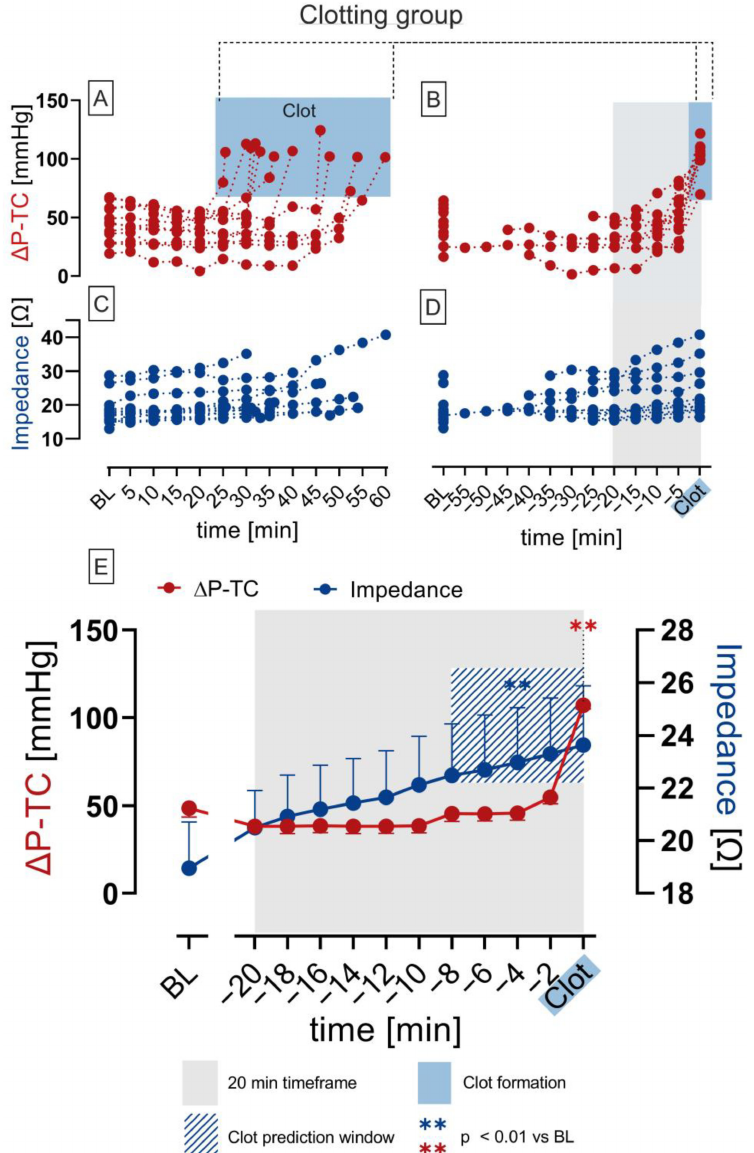
Figure 6. Impedance and pressure difference measurements ( ∆ P-TC) over time of clotting group (0.5 IU/mL heparin) with fulminant clot formation ( n = 12). Overview of ∆ P-TC ( A ) and impedance ( C ) of each experiment starting from baseline to termination. ∆ P-TC ( B ) and impedance ( D ) arranged and regarded 20 min retrospectively (grey box) from the endpoint of the experiments with fulminant clot formation (blue box). Mean ± SEM of ∆ P-TC and impedance in the 20 min timeframe prior to fulminant clot formation. Significant increase in impedance 8 min before significant increase in ∆ P-TC (blue stripes window; ( E )); ANOVA; ** p < 0.01 vs. baseline